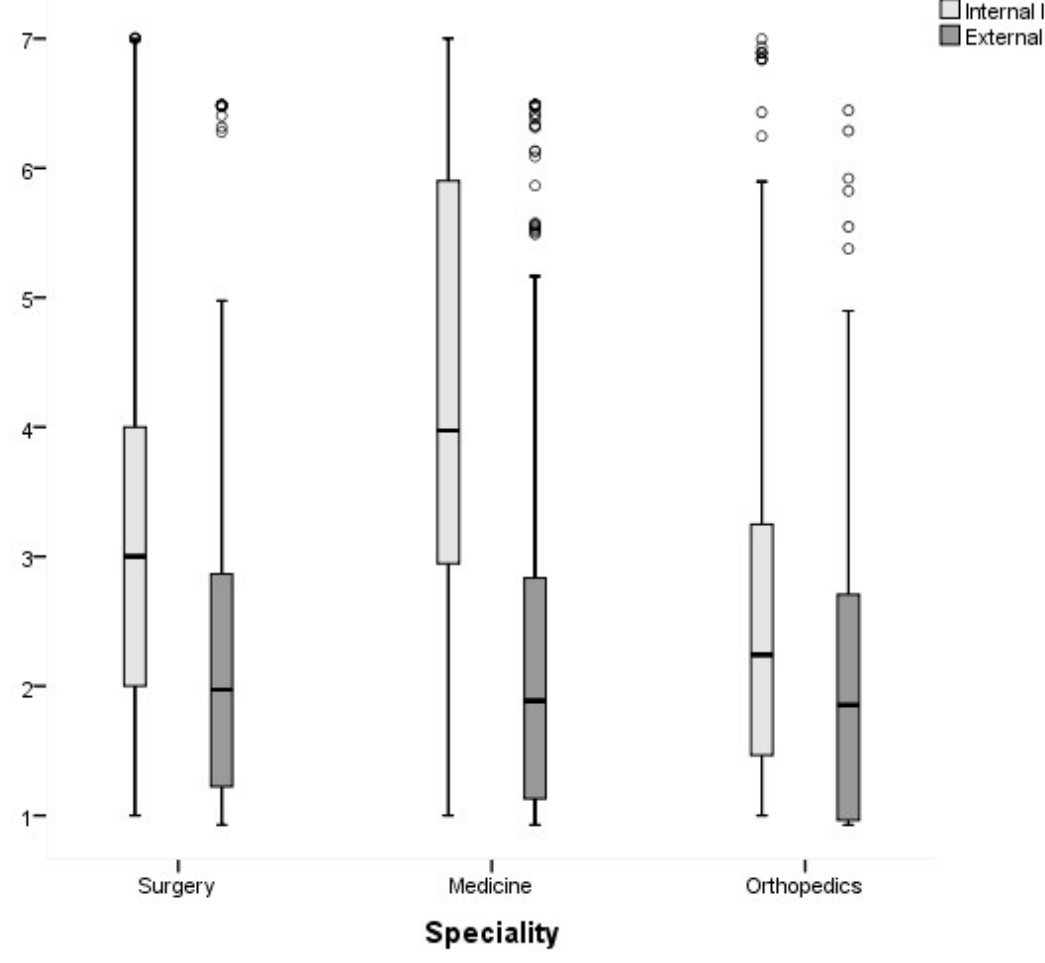
Figure 1. Distribution of nurses’ internal and external intent to leave, according to the unit’s specialty.